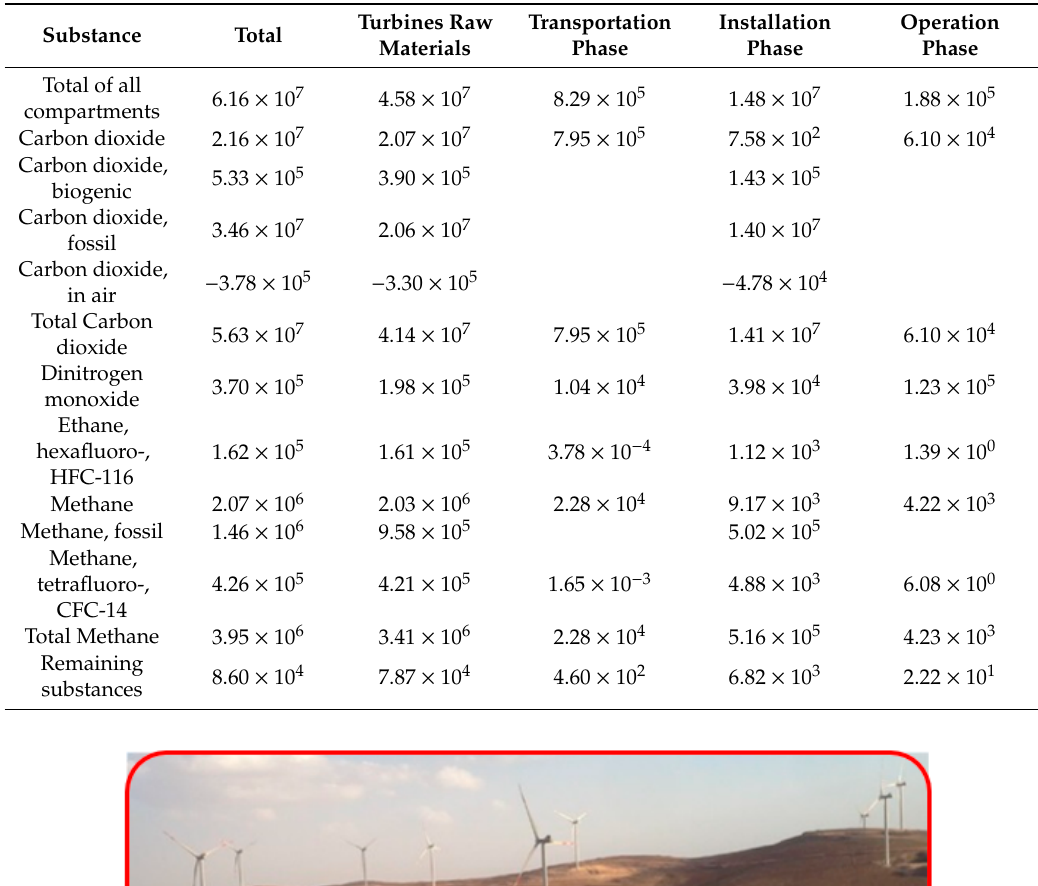
Table A4. Global warming substances for di ff erent phases.